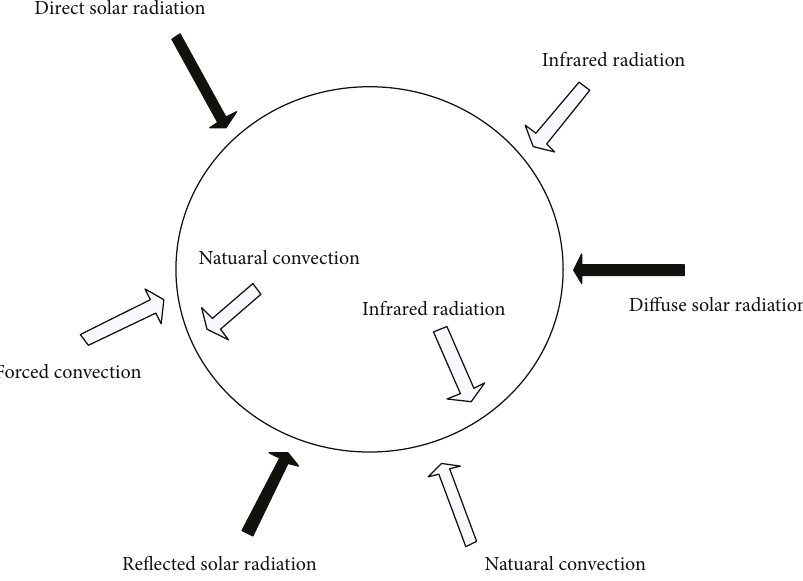
Figure 1: Thermal environment of a stratosphere